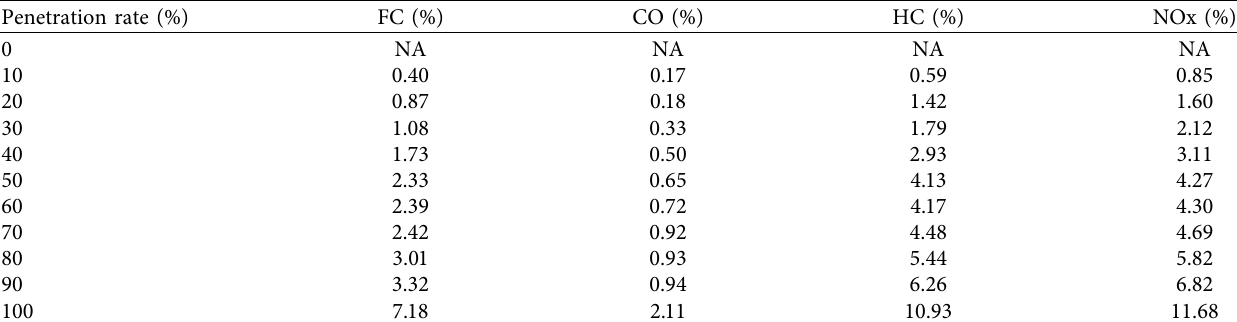
Figure 7: Fuel consumption and traffic emissions under different penetration rates of CAVs (Scenario 2). (a) Fuel consumption. (b) CO. (c) HC. (d) NOx. Table 6: Percentage reduction in fuel consumption and traffic emissions (Scenario